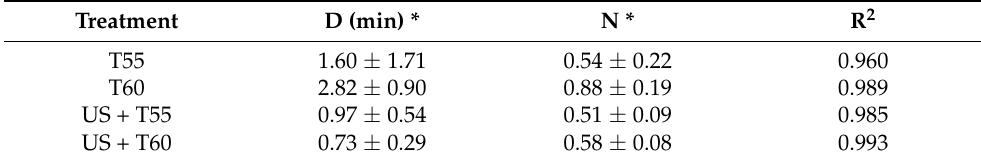
Table 3. Weibull model parameters and R 2 obtained for the different treatments.